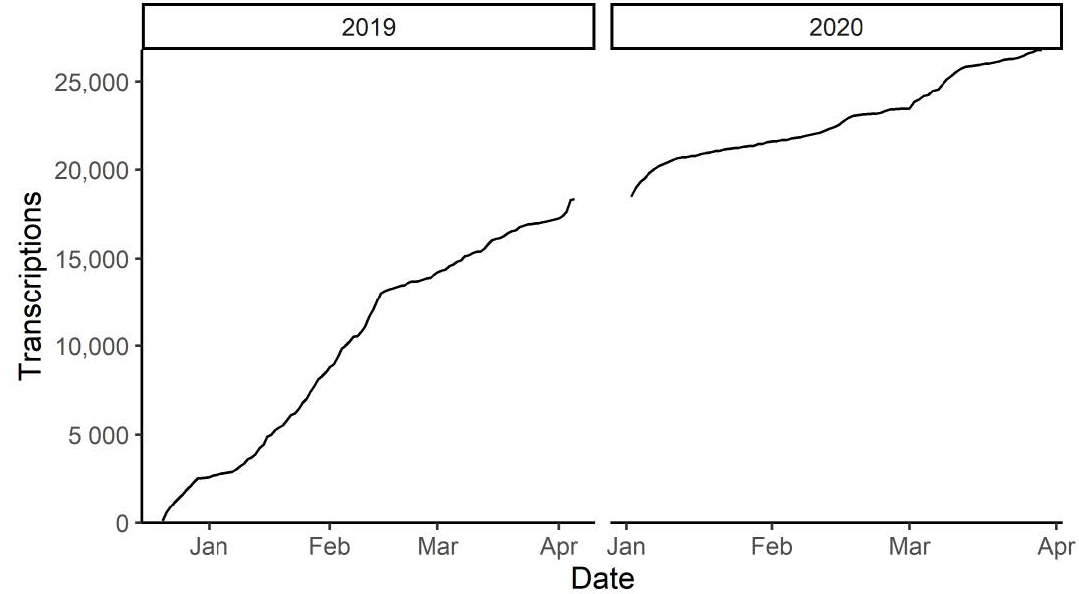
Figure 2. The cumulative transcriptions of five completed expeditions with specimens from Benton and Washington Counties, Arkansas, USA, in the Plants of Arkansas project on Notes from Nature. The top user group, Central Arkansas Master Naturalists (CAMN), contributed 10,851 transcriptions (41%, Table 1, Table S2). Mega-contributors transcribed 9,157 speci- mens (34%), followed by Northwest Arkansas Master Naturalist members contributing 2,516 transcriptions (9.4%, Table 1, Table S2). Students from Arkansas State University contributed 535 transcriptions (2%), with 14 Plant Systematics students completing a class assignment and at least 34 additional students transcribing during a WeDigBio event. In total, 14,007 transcriptions (52%) are attributed to 104 Arkansan transcribers. Table 1. User groups organized by the total number of transcriptions produced by each group (as in [43]). Unassigned includes usernames that were not recognized to belong to a particular group. User groups included Mega-contributor for global users completing > 10,000 transcriptions on the Plants of Arkansas project, Team for members of the Plants of Ar- kansas core team who are the lead researchers and project moderators, CAMN for users in Central Arkansas Master Nat- uralists organization (engaged January 2019), NWAMN for users in Northwest Arkansas Master Naturalists organization (trained January 2020), combined Arkansas Master Naturalist groups (Northeast Arkansas and Diamond Lakes) with Ar- kansas Native Plant Society (ANPS) members, and students from A-State.